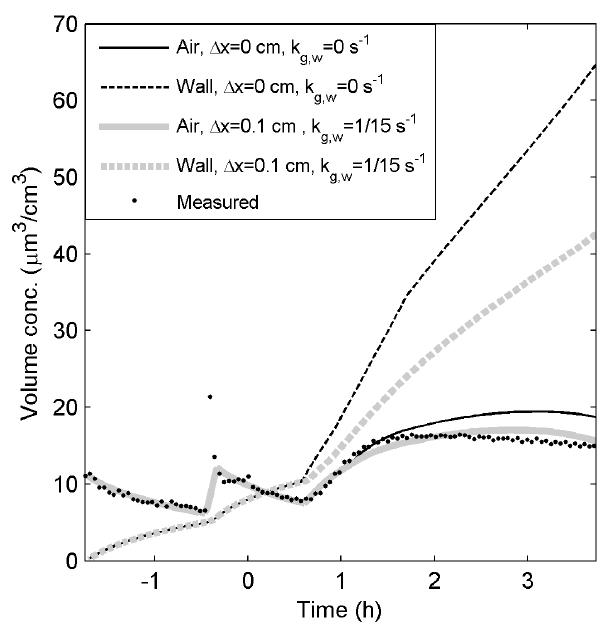
Figure 15. Modelled and measured volume concentrations (seed aerosol + SOA coating) during the m -xylene oxidation experiment from Nordin et al. (2013). The model results are from simula- tions with relatively rapid ( k f = 10 − 22 molecules − 1 cm 3 s − 1 ) per- oxyhemiacetal and hemiacetal formation, 1x = 0 or 0.1cm and k g , w = 0 or 1 / 15s − 1 . The model results are given both for the par- ticles in the air and the particles deposited on the chamber